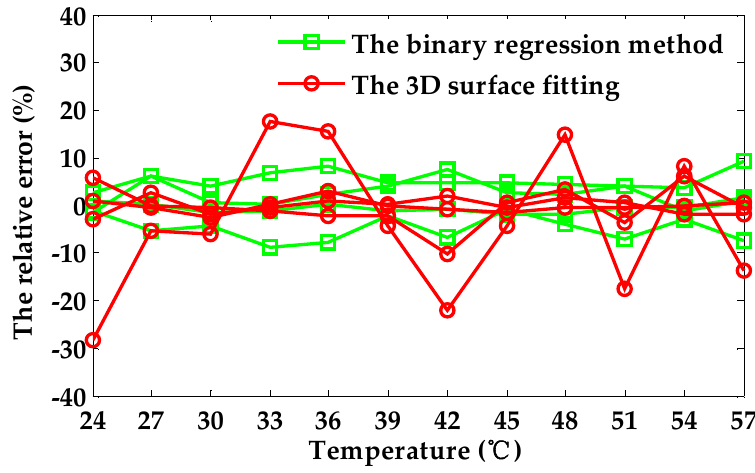
Figure 3 . The comparison of the compensation error using two different methods.